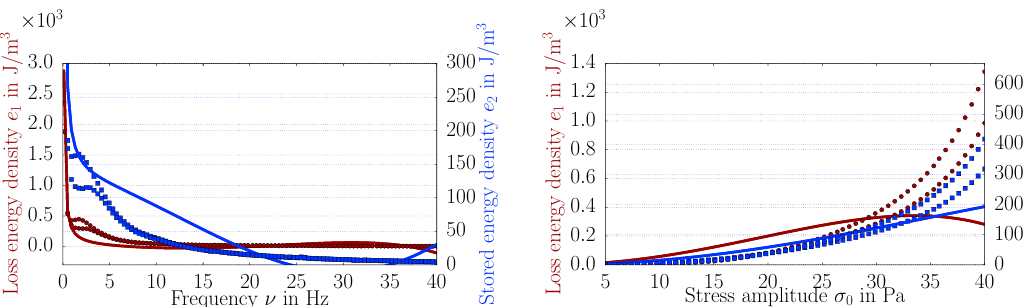
Figure 4. Cubic model, loss (red circles) and stored (blue squares) energies obtained from the measurement; corresponding fit curves as continuous lines. Left: Frequency variation by fixed amplitude, σ 0 = 40Pa. Right: Amplitude variation by fixed frequency, ν = 1Hz.